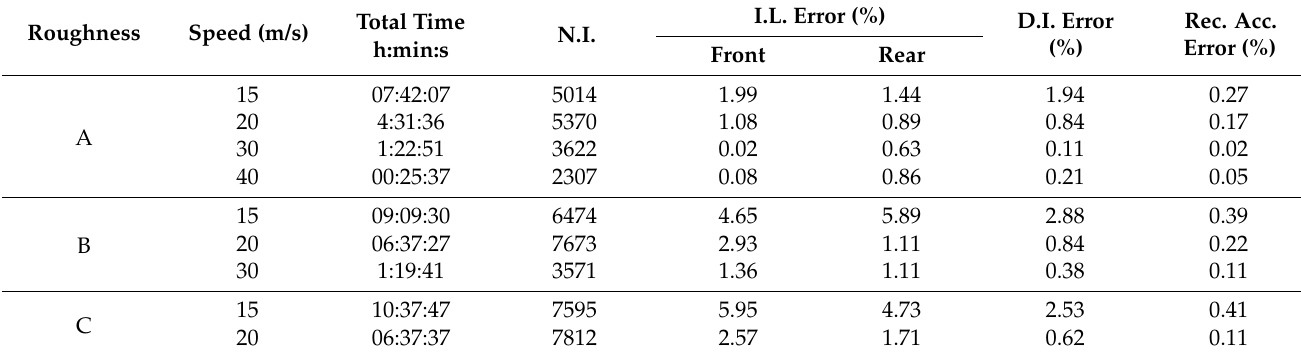
Table 7. Identification results from different road roughness levels and vehicle speeds.